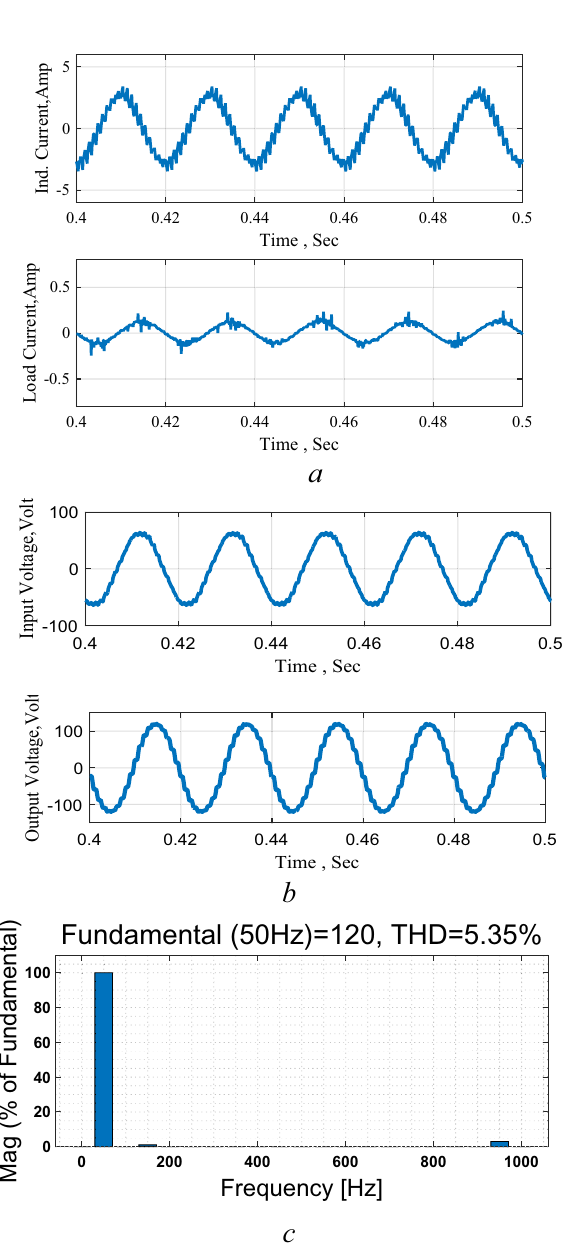
Figure 18. Circuit performance as an AC–AC converter. ( a ) Inductor and output currents, ( b ) input and output voltages, ( c ) THD